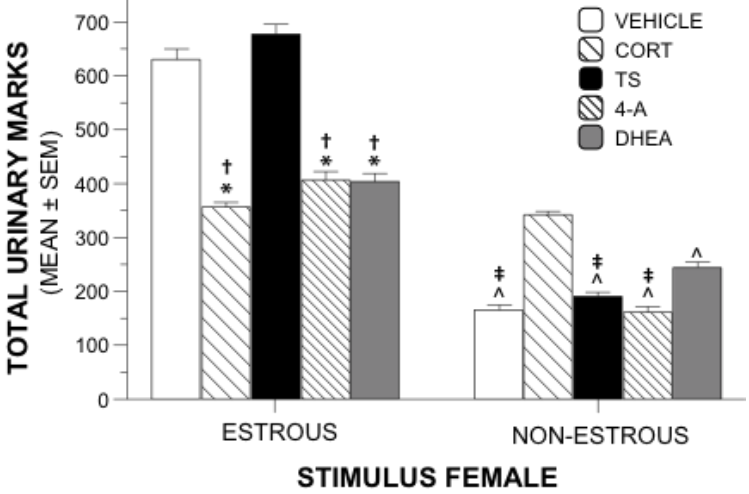
Figure 2. Urinary Marking Behavior. Mean (±SEM) total urinary marks near stimulus females during sexual motivation testing. Groups of males were gonadally intact and were administered supplements of steroid or vehicle during 3 weeks of testing. (*) Significantly different from TS; (†) Significantly different from vehicle; (^) Significantly different from CORT; (‡); Significantly different from